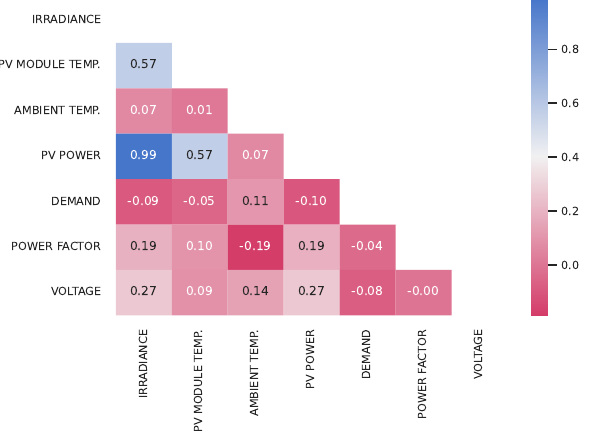
Figure 3. Correlation matrix between the variables in the database.